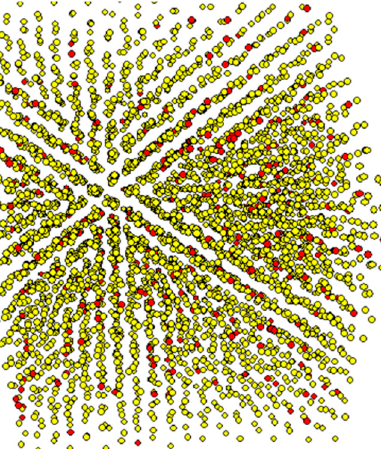
Figure 8. The image of atomic distribution at a defined annealing temperature for Pt 90 -Pd 10 and 700 K. (yellow atoms are Pt atoms).